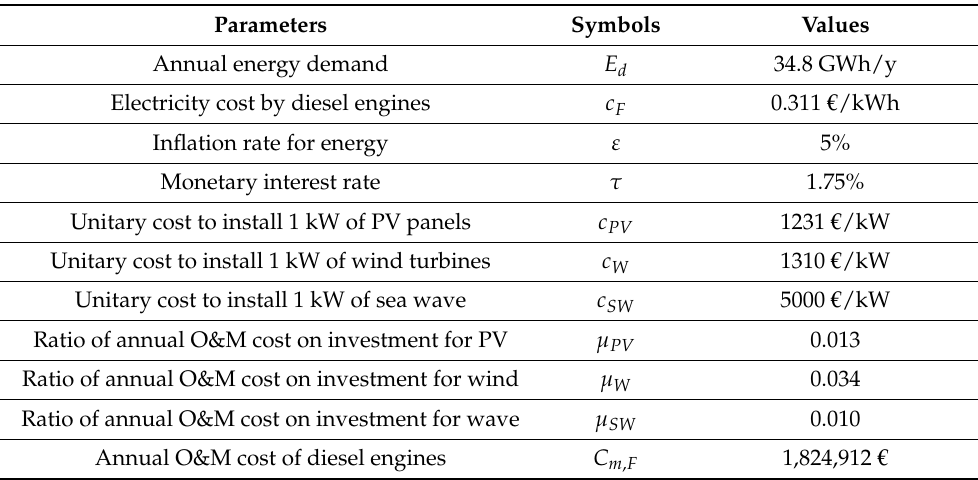
Table A8. Values of main parameters used in the evaluation on Lipari Island.